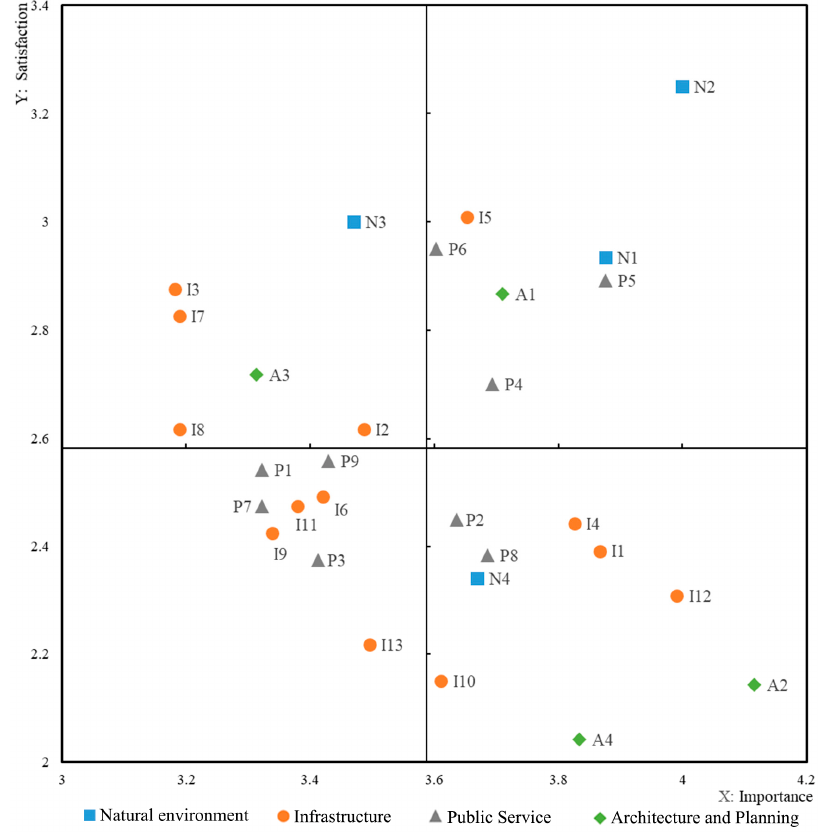
Figure 6. IS matrix